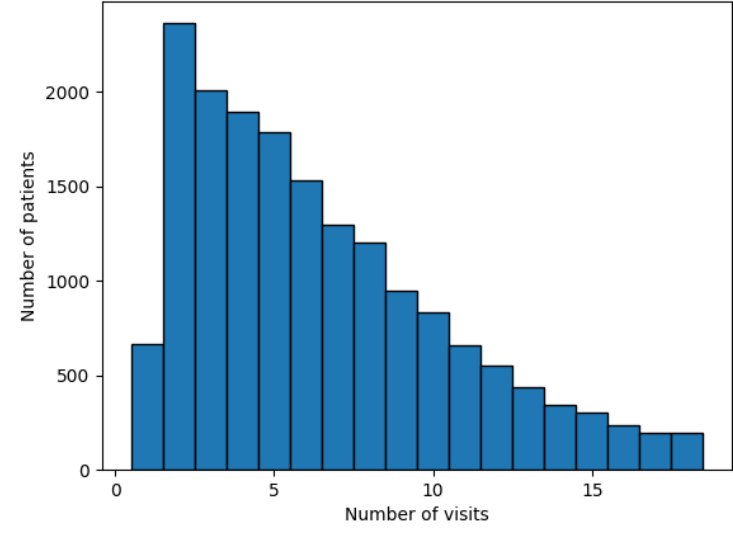
Figure 11. Histogram showing the trend in the number of visits made by patients.